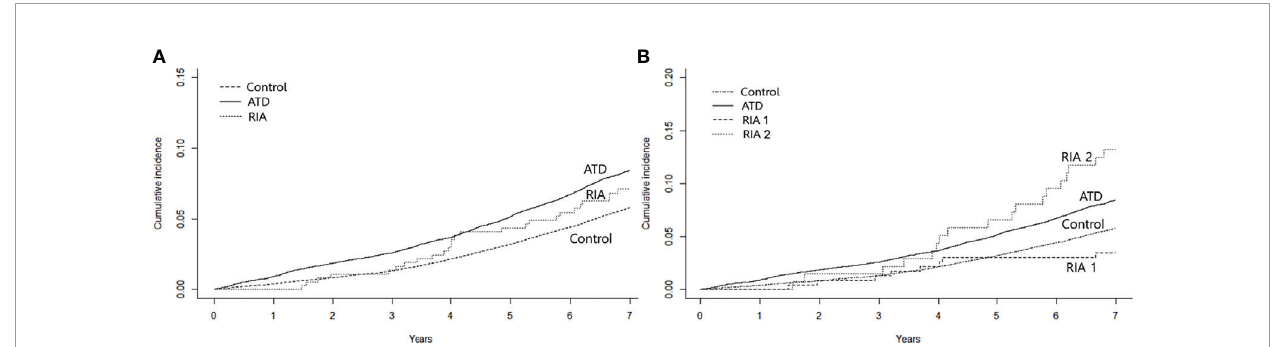
FIGURE 2 | Kaplan – Meier curves for cumulative incidence of heart failure. (A) shows the incidence according to the treatment modality after 2 years of anti-thyroid drug therapy and (B) shows the incidence by taking into account whether remission was achieved after ablation. ATD, group that continued to receive anti-thyroid drug; RIA, group that underwent radioactive iodine ablation; RIA 1, group that underwent radioactive iodine ablation and achieved remission; RIA 2, group that underwent radioactive iodine ablation and did not achieve remission.